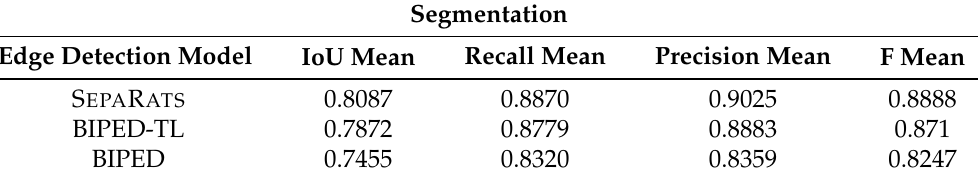
Table 3. Evaluation of the segmentation method, combining edge based regions (from the trained models S EPA R ATS and BIPED-TL, and the baseline BIPED) and regions from body part detection. The 471 frames of the test dataset with occluding instances were used for evaluation. IoU is calculated without tails. Mean values over the instances are shown for each metric. For all 471 frames there are at least two connected foreground regions with different labels, i.e., both ID labels are present on each